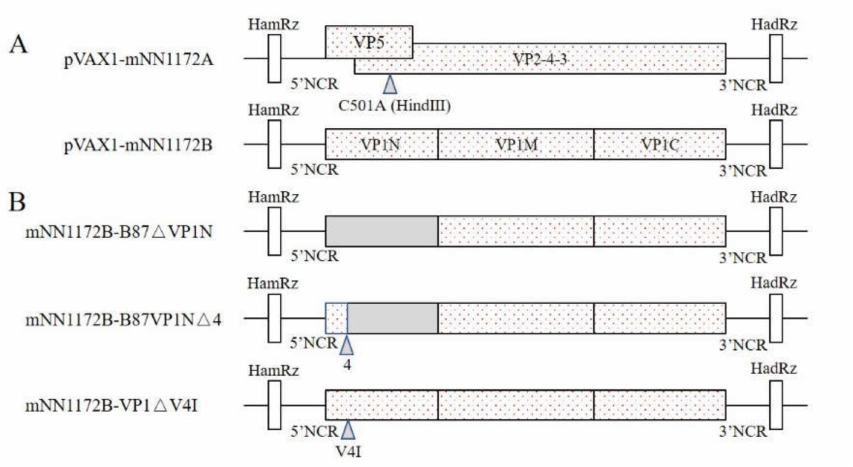
Figure 1. Schematic representation of the unique restriction enzyme site ( Hind III) was introduced into the Infectious Bursal Disease Virus genome ( A ) and construction of mosaic B segments derived from NN1172 (open boxes) and B87 (shaded boxes) ( B